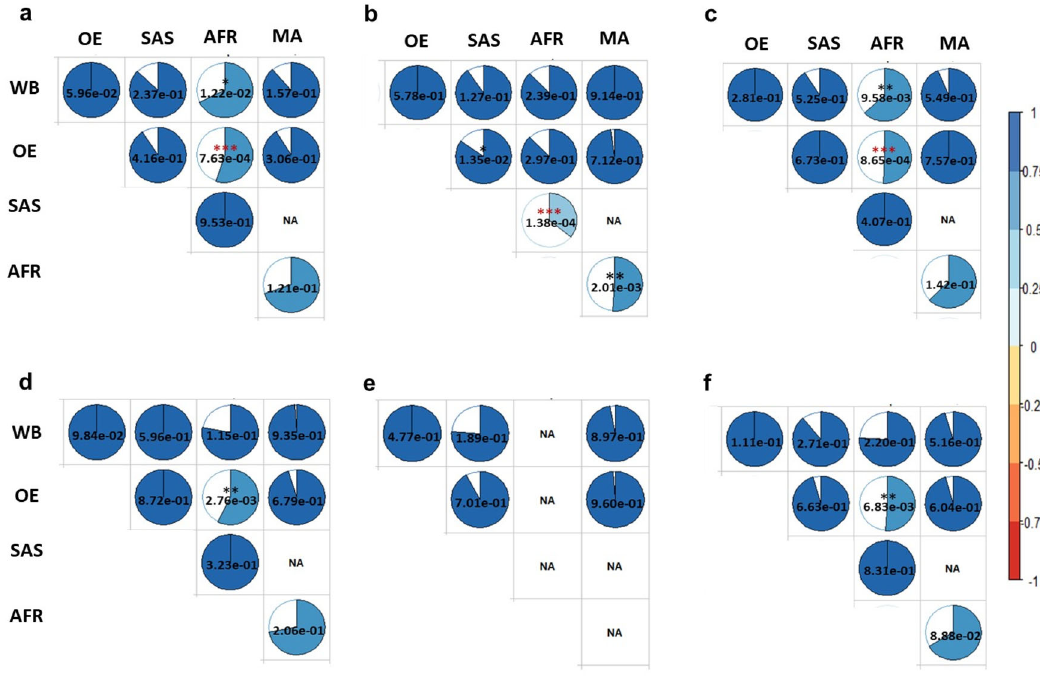
Fig. 5 | Estimated cross-ancestry genetic correlations for anthropometric traits. The phenotypes are a BMI b Standing height, c Waist circumference, d Hip circumference, e Waist-hipratioand f Weight.Thecolourandsizeofeachpiechart indicates the magnitude of estimated cross-ancestry genetic correlations. WB, OE, SAS, and AFR indicate White British, Other European, South Asian, and African ancestrycohorts.Thevalueineachpiechartisa p -value(*,**and***indicate p value